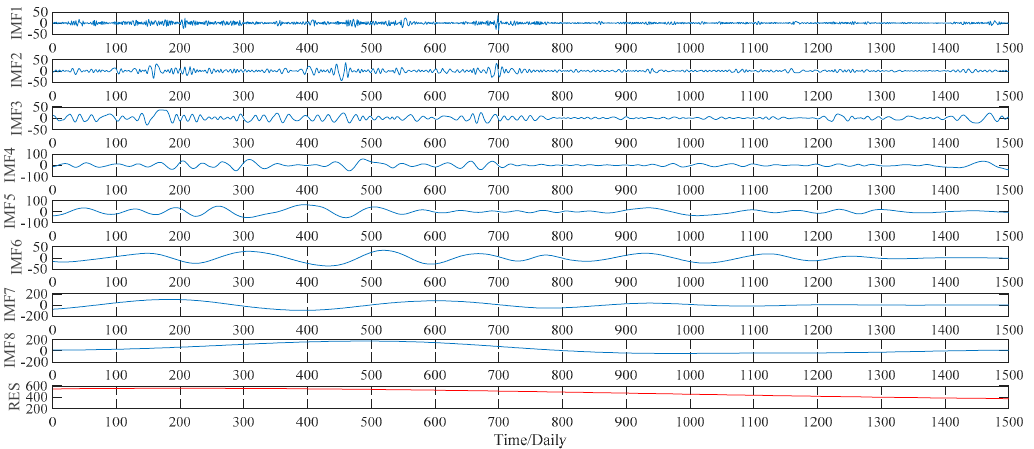
Figure 13. Decomposition results of the EMD method (corn).